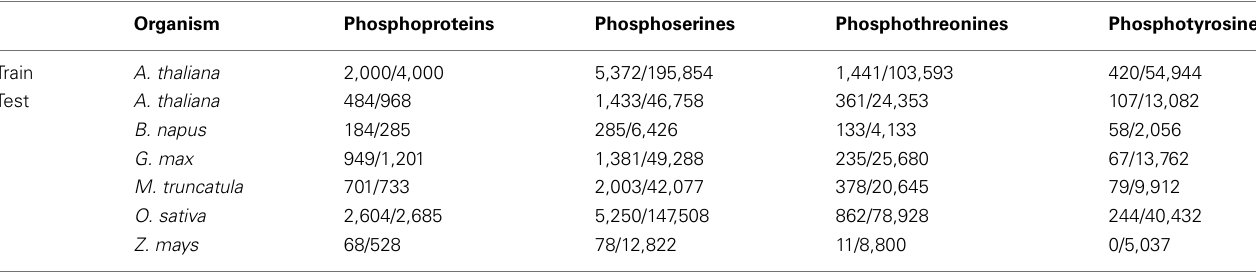
Table 1 |Training and testing